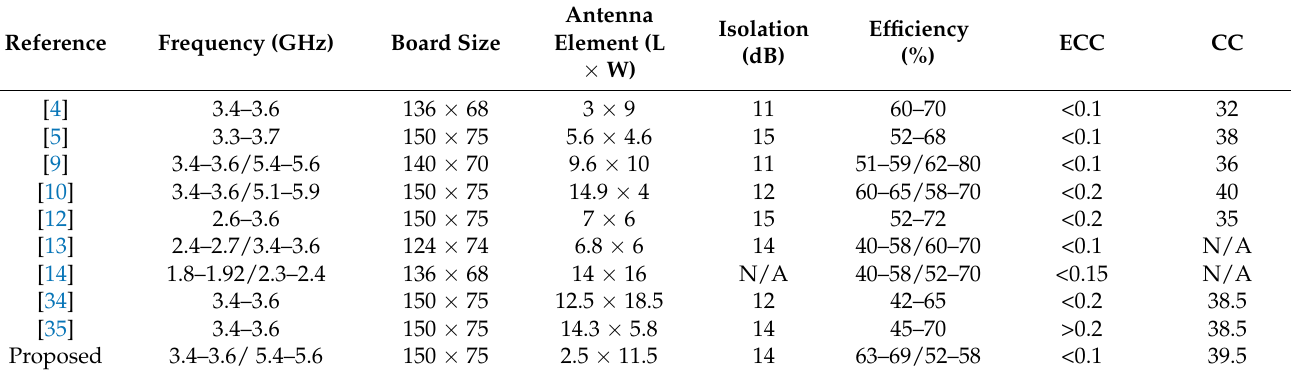
Table 2. Comparison Table of proposed MIMO